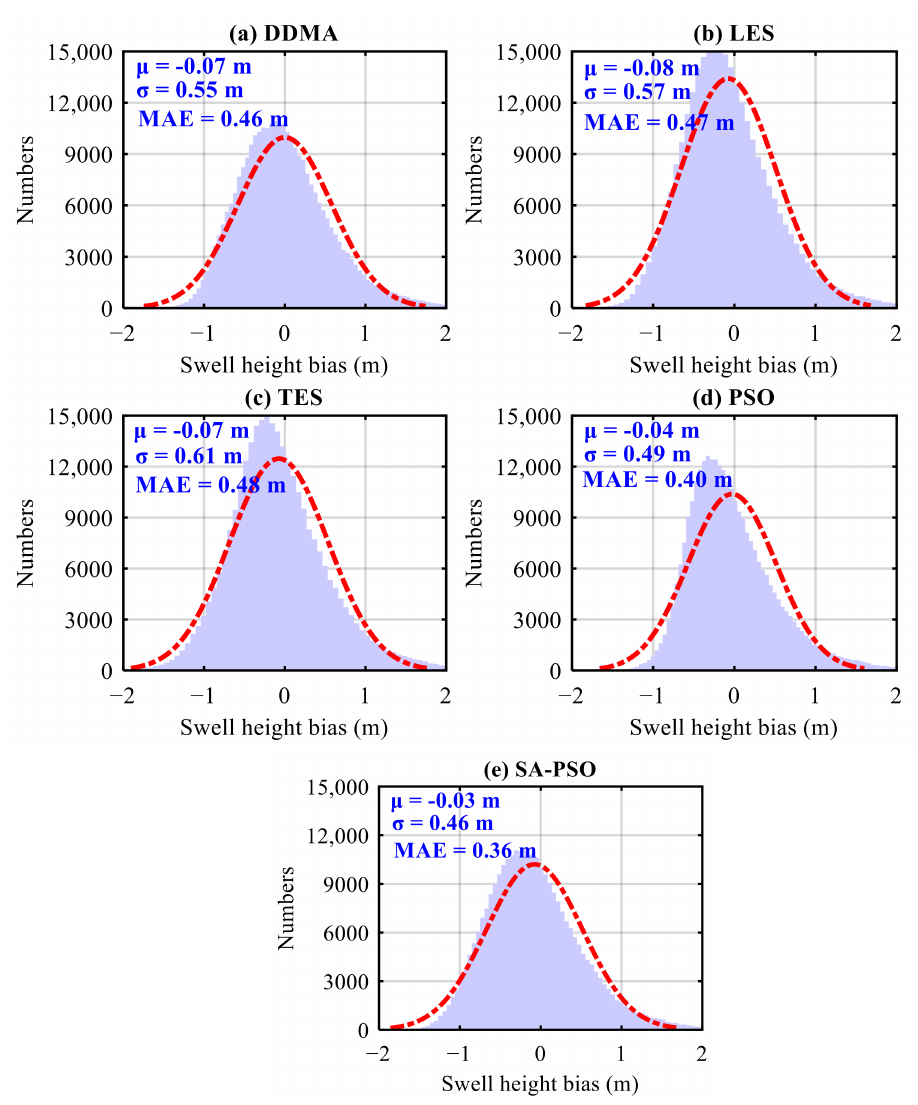
Figure 13. The deviation distribution histogram between the swell height calculated by GNSS-R and the reference data, ERA5 data. ( a ) DDMA, ( b ) LES, ( c ) TES, ( d ) PSO, and ( e ) SA-PSO.